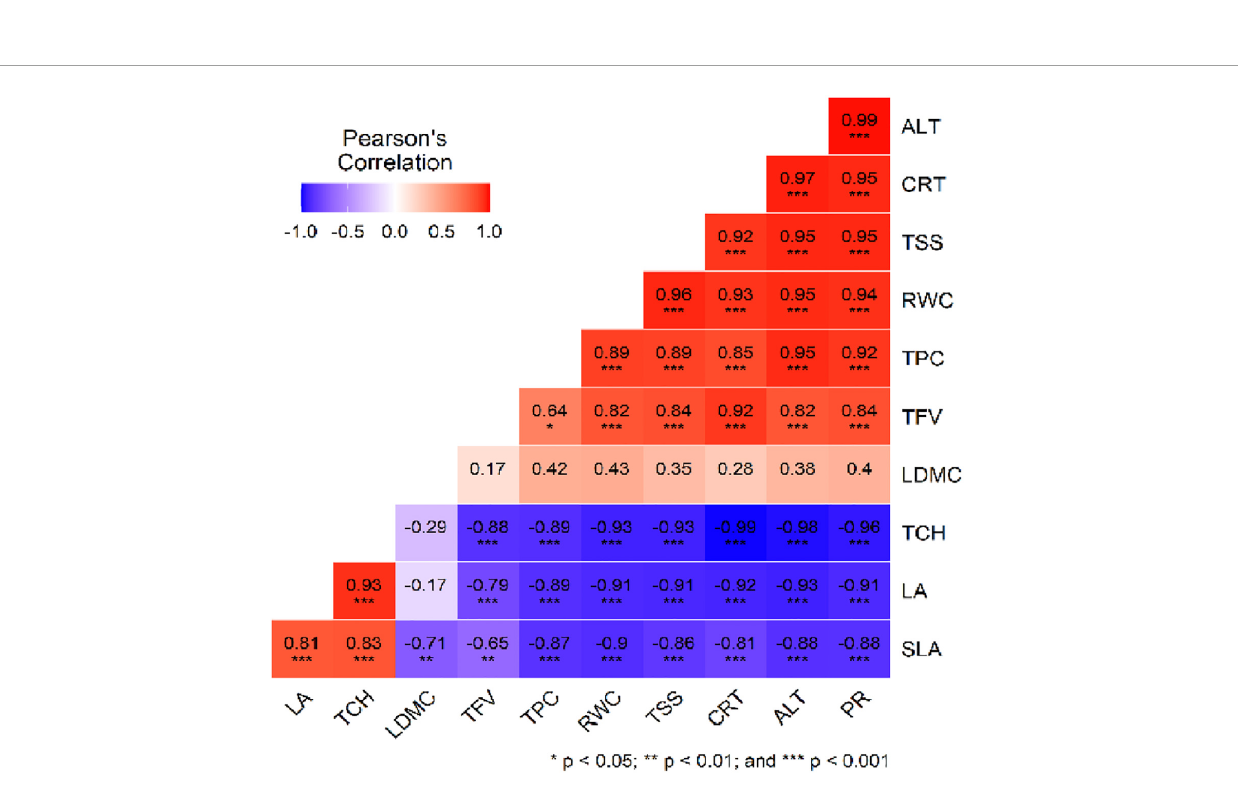
FIGURE7 Pearson’s correlation plot of the eco-physiological parameters and altitude. The distribution of each variable and correlation coefficient plus the significance level is given in the figure. Full forms of abbreviations are presented in Figure 6 .